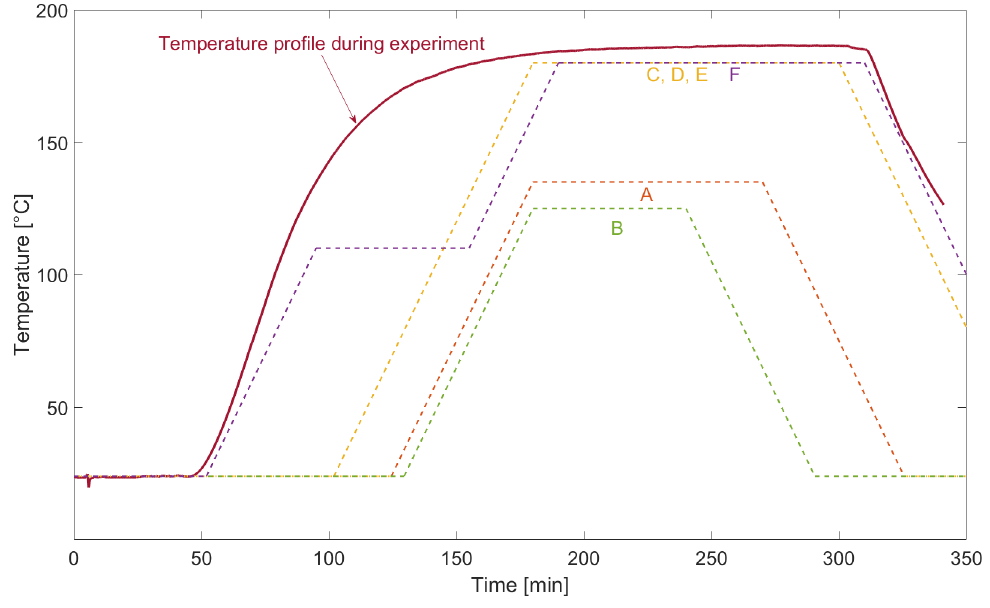
Figure 7. Temperature profile inside miniature autoclave for system temperature conformity tests. A–F recommended curing cycles for prepregs (see Table